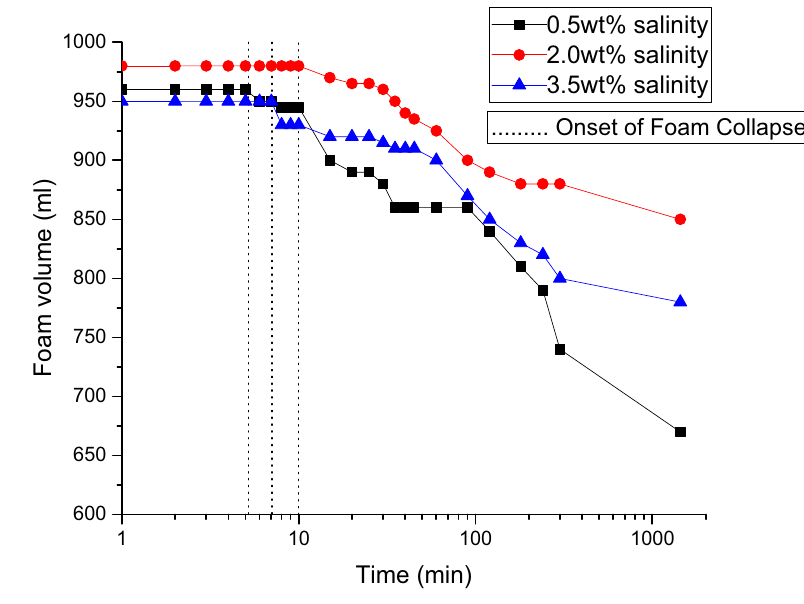
Fig. 4 Determination of salinity effect by using the bulk foam stability test